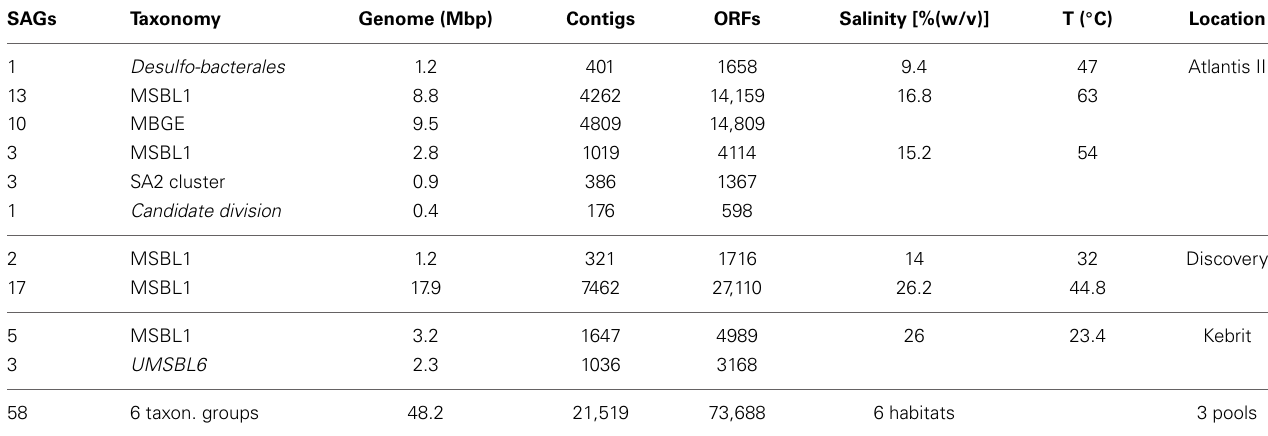
Table 3 | Bacterial ( italic ) and archeal SAGs from thermophilic and hypersalinic sampling regions selected for this study.